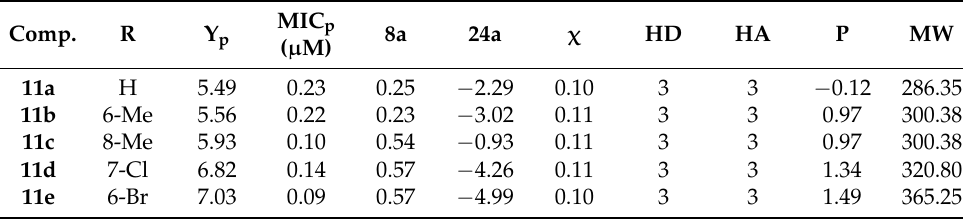
Table 4. Molecular descriptor values and minimum inhibitory concentration predicted for five compounds designed using the QSAR model obtained